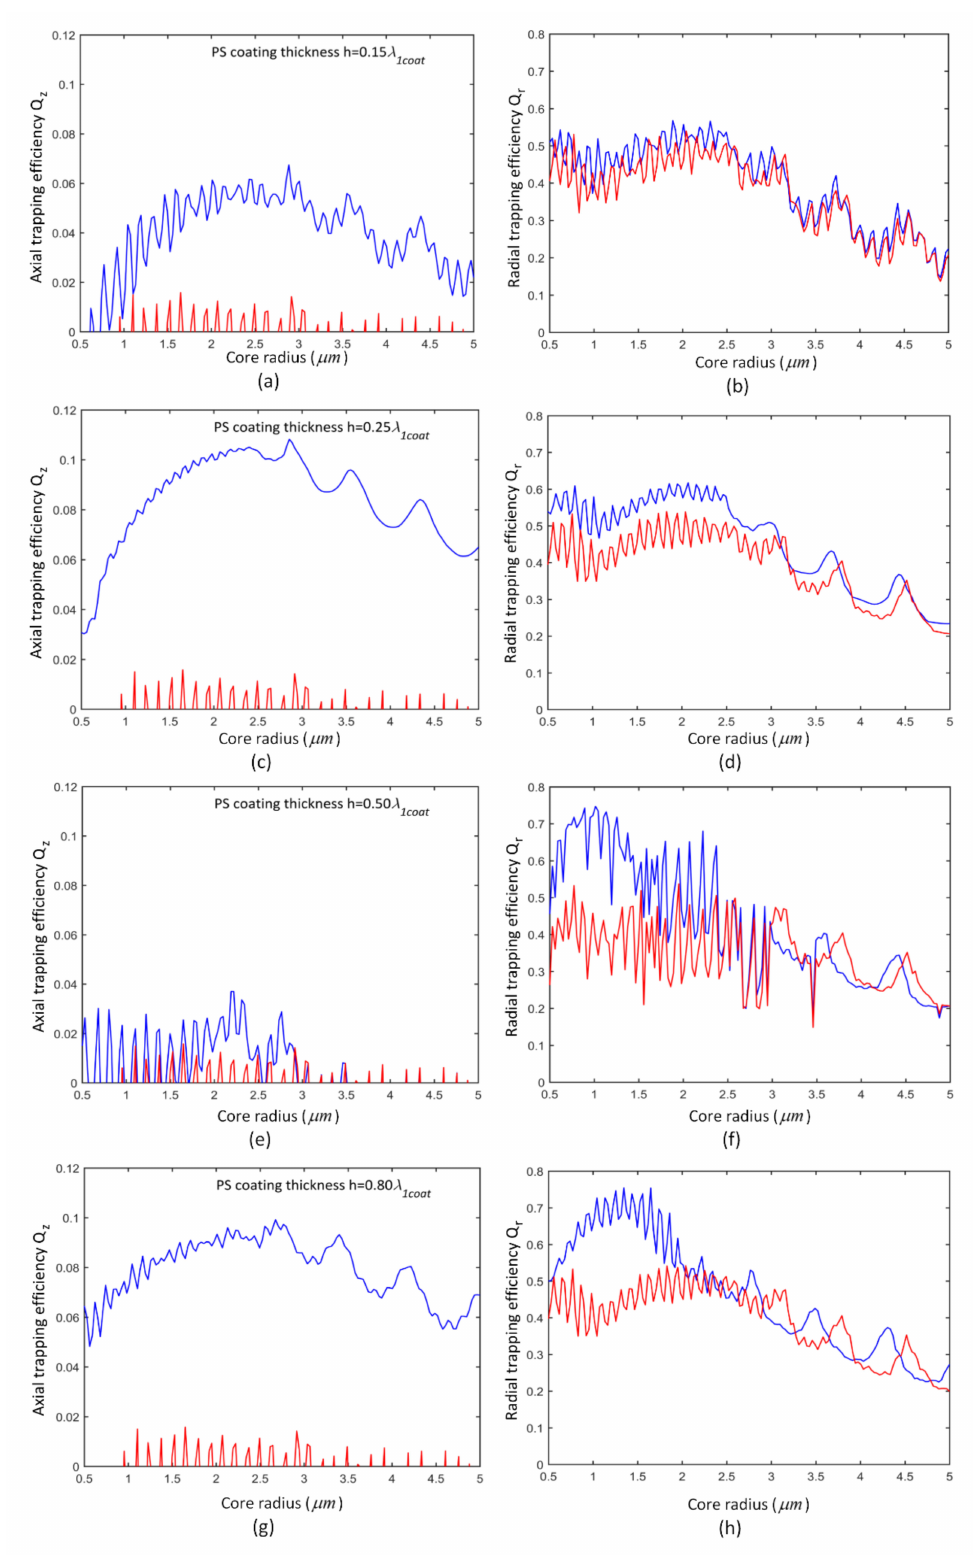
Figure 3. Maximum axial trapping e ffi ciency Q z and maximum radial trapping e ffi ciency Q r for coated (in blue) and uncoated (in red) high-refractive BTG spheres with a varied PS coating thickness. The BTG core radius was set in a range of 0.5 µ m–5 µ m. Four di ff erent PS coating thickness are illustrated: h = 0.15 λ 1 coat for ( a , b ); h = 0.25 λ 1 coat for ( c , d ); h = 0.50 λ 1 coat for ( e , f ); h = 0.80 λ 1 coat for ( g , h